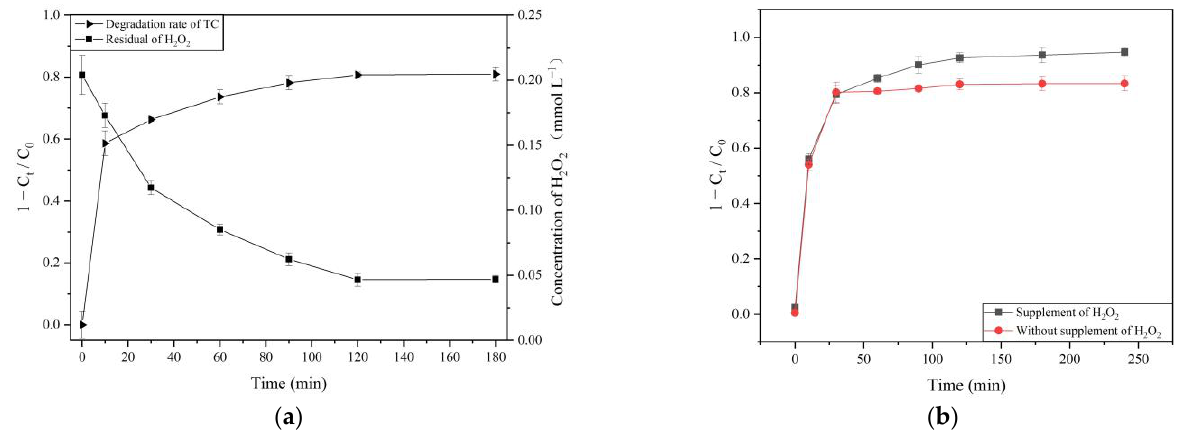
Figure 1. Degradation of tetracycline, residual of H 2 O 2 ( a ), and impact of H 2 O 2 supplementation ( b ) in MnP system.